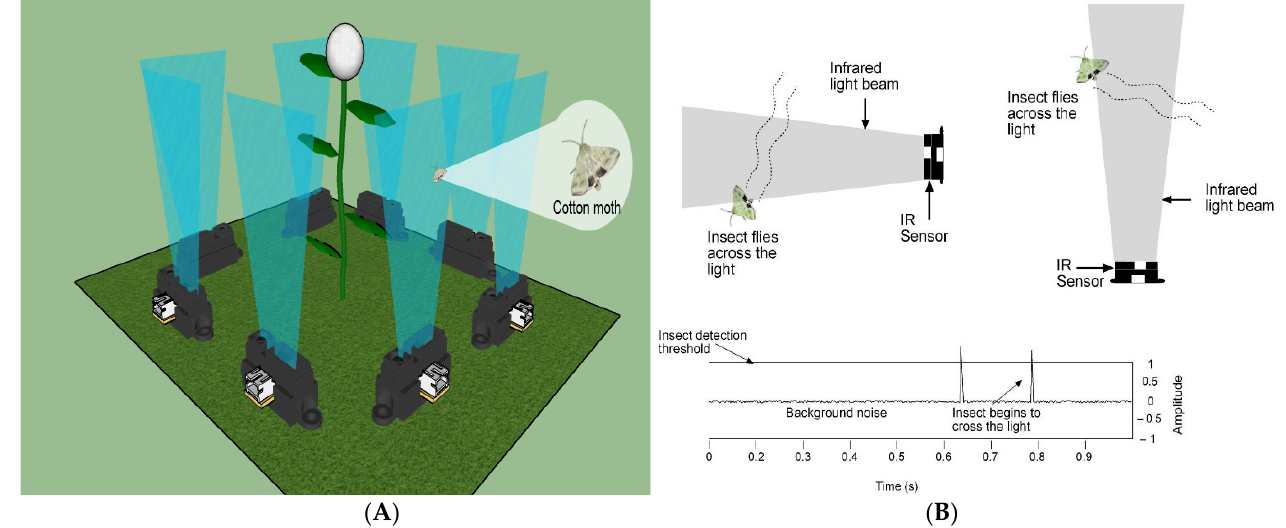
Figure 2. ( A ) Operational schematic of implementation. ( B ) Operating principle of the sensor.